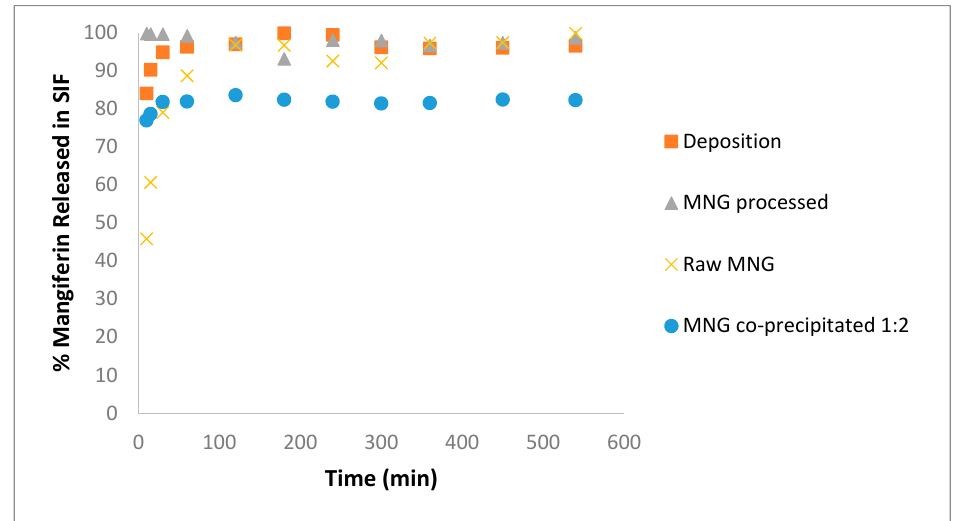
Figure 9. Release test of MNG from composites in SGF corresponding to experiment 6 (180 bar, 323 K, 30 g/min CO 2 flow rate, SAS1).